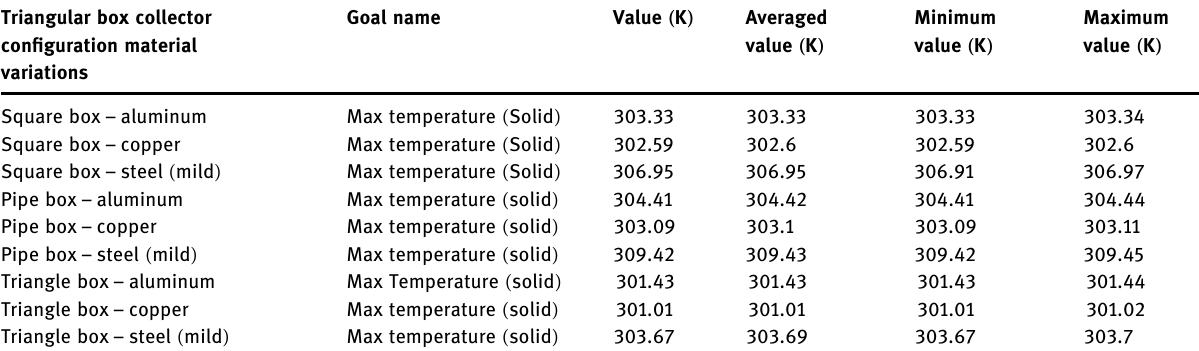
Table 6: Simulation results of alloy variations in the shape and thermal collector material